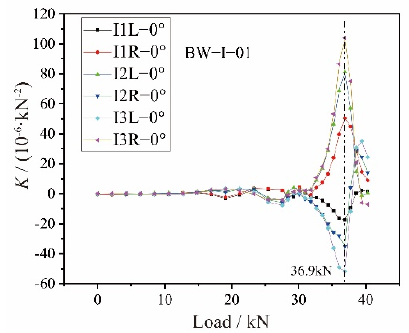
Figure 6. The characteristics of the off-plane deformation on the BW-I-01 composite beam web corresponding to the shear buckling: ( a ) the off-plane buckling deformation of Point A and the nearby region; ( b ) the off-plane buckling deformation of Point B and the nearby region; ( c ) the off-plane buckling deformation of Point C and the nearby region.